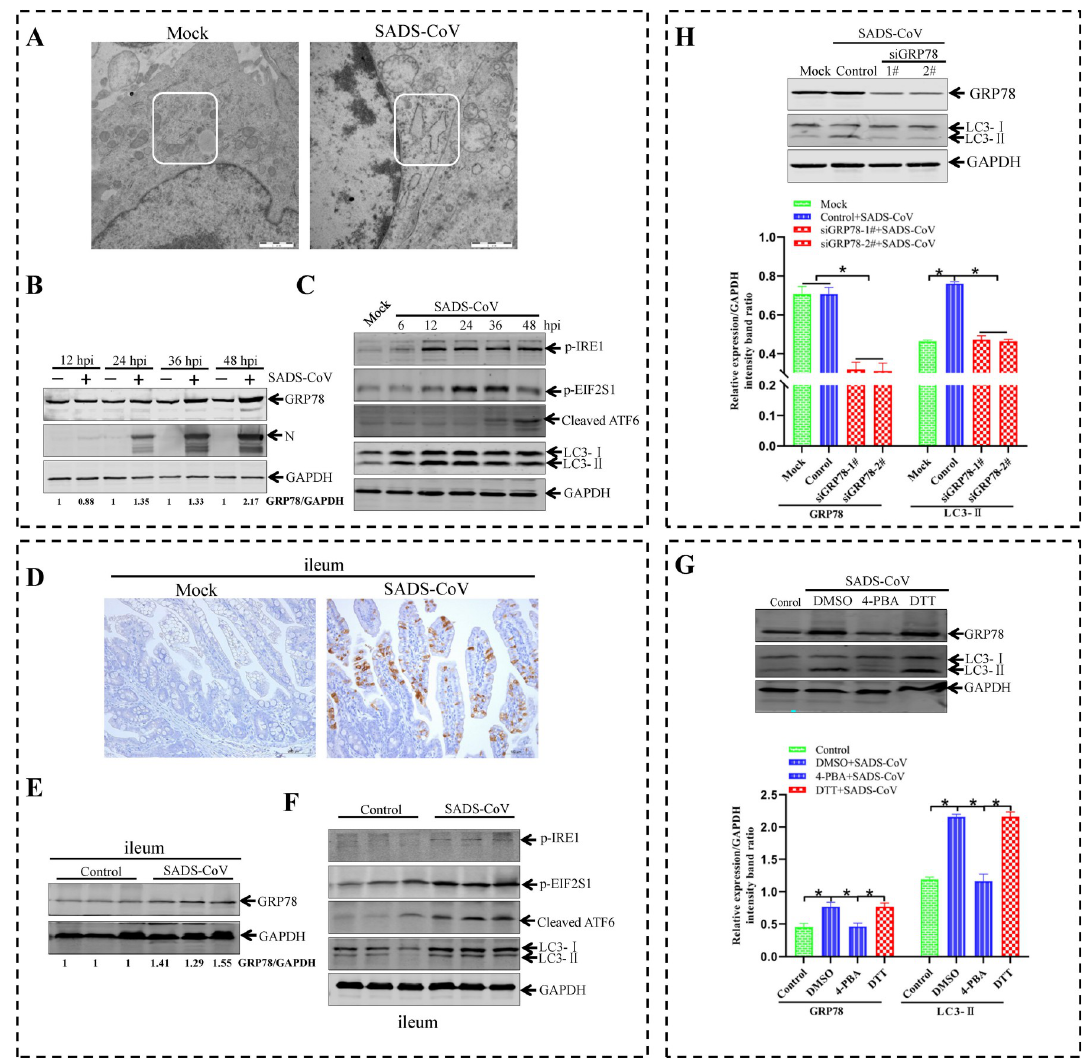
Fig 6. SADS-CoV triggers autophagy through activating ER stress. ( A-C ) SADS-CoV infection causes ER stress by activating all three UPR pathways in vitro . ( A ) Expansion of the ER is detected with transmission electron microscopy (TEM). Vero E6 cells, either mock-infection or infection with SADS at an MOI of 0.1, are analyzed for the ER expansion via electron microscopy at 36 hpi. The square region highlights ER stress. Scale bar indicates 1 μ m. ( B ) ST cells are mock mock-infected or infected with SADS-CoV at the indicated time points (12, 24, 36 and 48 hpi) to analyze GRP78 protein expression by western blotting using anti-viral N, anti-GRP78, and anti-GAPDH antibodies. The densities of GRP78 bands were analyzed to calculate the values relative to that of GAPDH. Results were normalized to respective control cells. ( C ) SADS-CoV infection activates all three UPR signaling pathways in vitro . ST cells are infected with SADS-CoV at an MOI of 0.1 and harvested at 6, 12, 24, 36, and 48 hpi. Cell lysates are subjected to a western blotting analysis with antibodies against p-IRE1, p-EIF2S1, ATF6, and LC3. GAPDH is used as a loading control. ( D-F ) SADS-CoV infection causes ER stress by activating all three UPR signaling pathways in vivo . ( D ) Representative microphotographs of viral antigen immunochemical staining in SADS-CoV-noninfected and -infected ileum tissue. Scale bars indicate 100 μ m. ( E and F ) Protein levels of GRP78, p-IRE1, p-EIF2S1, cleaved ATF6, and LC3 in ileum samples of SADS-CoV-noninfected and -infected piglets. The densities of GRP78 bands were analyzed to calculate the values relative to that of GAPDH. Results were normalized to respective control piglet. ( H ) ST cells are transfected with the siRNAs of GRP78 or siRNAs of negative control for 48 h, and followed by an infection with SADS-CoV at an MOI of 0.1 or mock infection. After 1 h of virus absorption at 37˚C, the cells are further cultured in maintenance medium. At 36 h after infection with mock or SADS-CoV, the cells are subjected to western blotting using anti-GRP78, anti-LC3 and anti-GAPDH antibodies. ( G ) Western blotting is used to analyze the expression of GRP78 and LC3 in SADS-CoV-noninfected and -infected cells in the absence or presence of the ER stress inhibitor 4-PBA (1 mM) or the ER stress inducer DTT (1 mM). Means and SD (error bars) of three independent experiments are indicated ( � P <